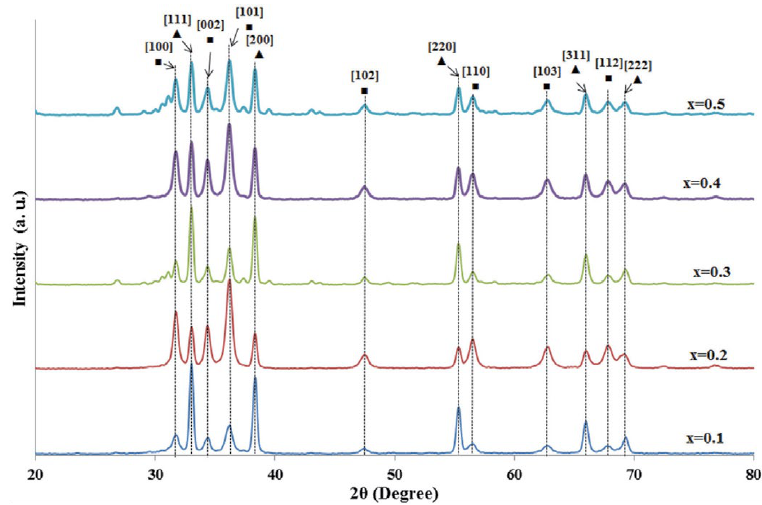
Fig. 2. X-ray diffraction pattern of different–ZnOsamples Fig. 2 X-ray diffraction pattern of different–ZnOsamples